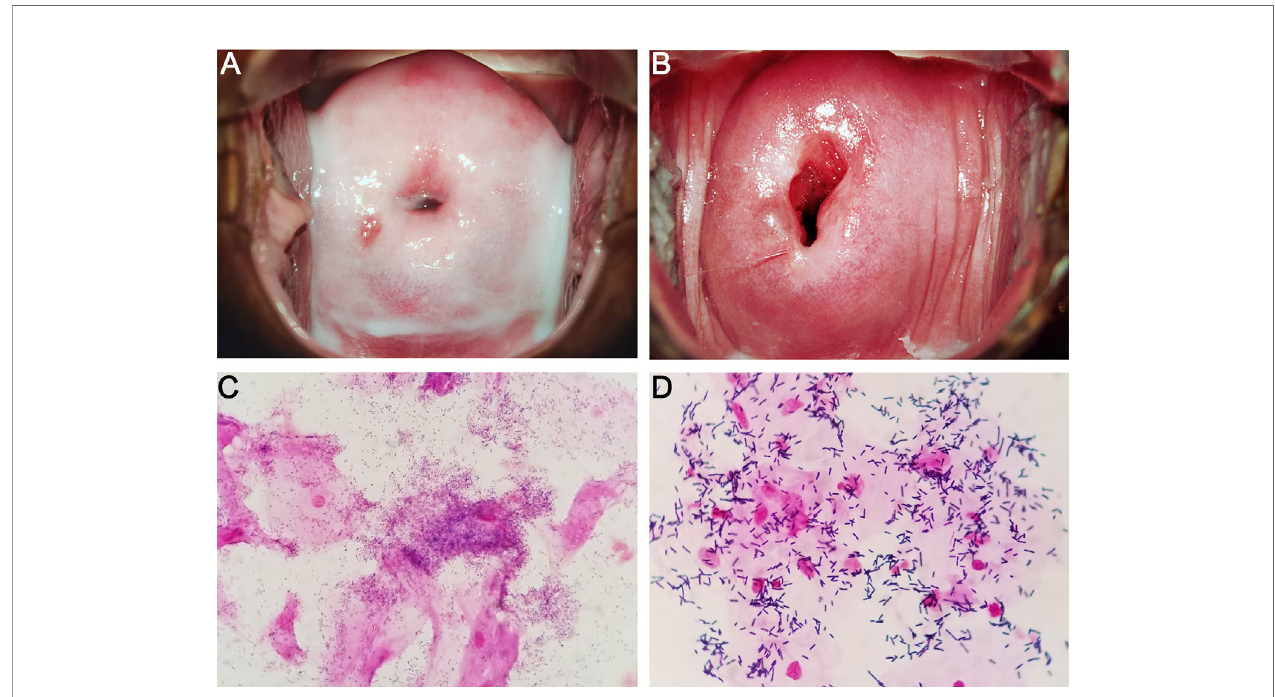
FIGURE 1 | Characteristics of BV (A, C) and normal (B, D) vaginal microbiome. (A, C) show the colposcopic and microscopic examination of BV vaginal discharges, respectively. Homogeneous and milk-like secretions, Gardnerella -like microbes, and clue cells are observed. (B, D) show the colposcopic and microscopic examinations of normal vaginal discharges, respectively. Homogeneous and clear secretions, Lactobacillus -like microbes, and no clue cells are